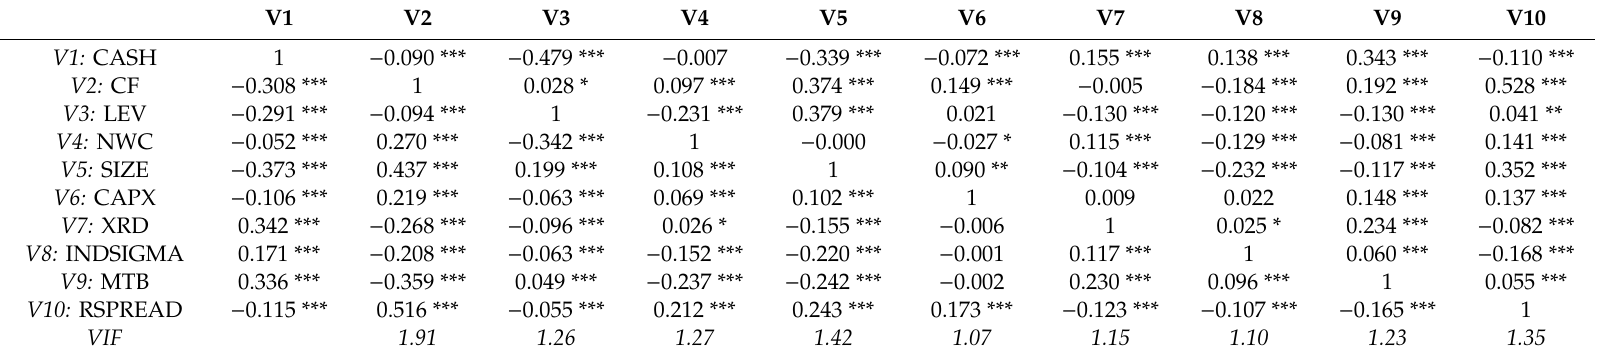
Table 4. Pearson (lower diagonal) and Spearman (upper diagonal)